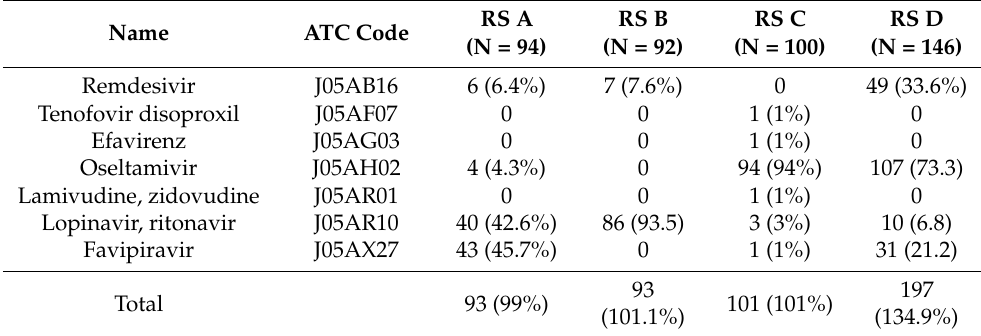
Table 3. Antivirals use during